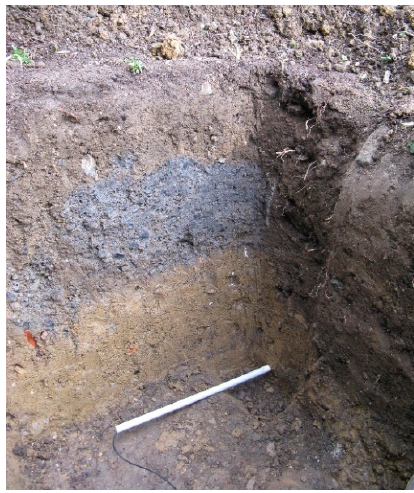
Figure 10. Example of a horizontal installation.